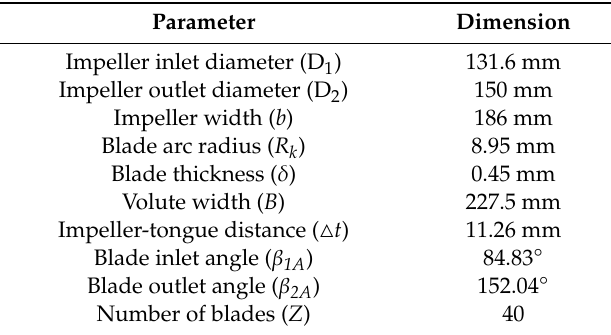
Table 1. Design dimensions for the centrifugal fan.